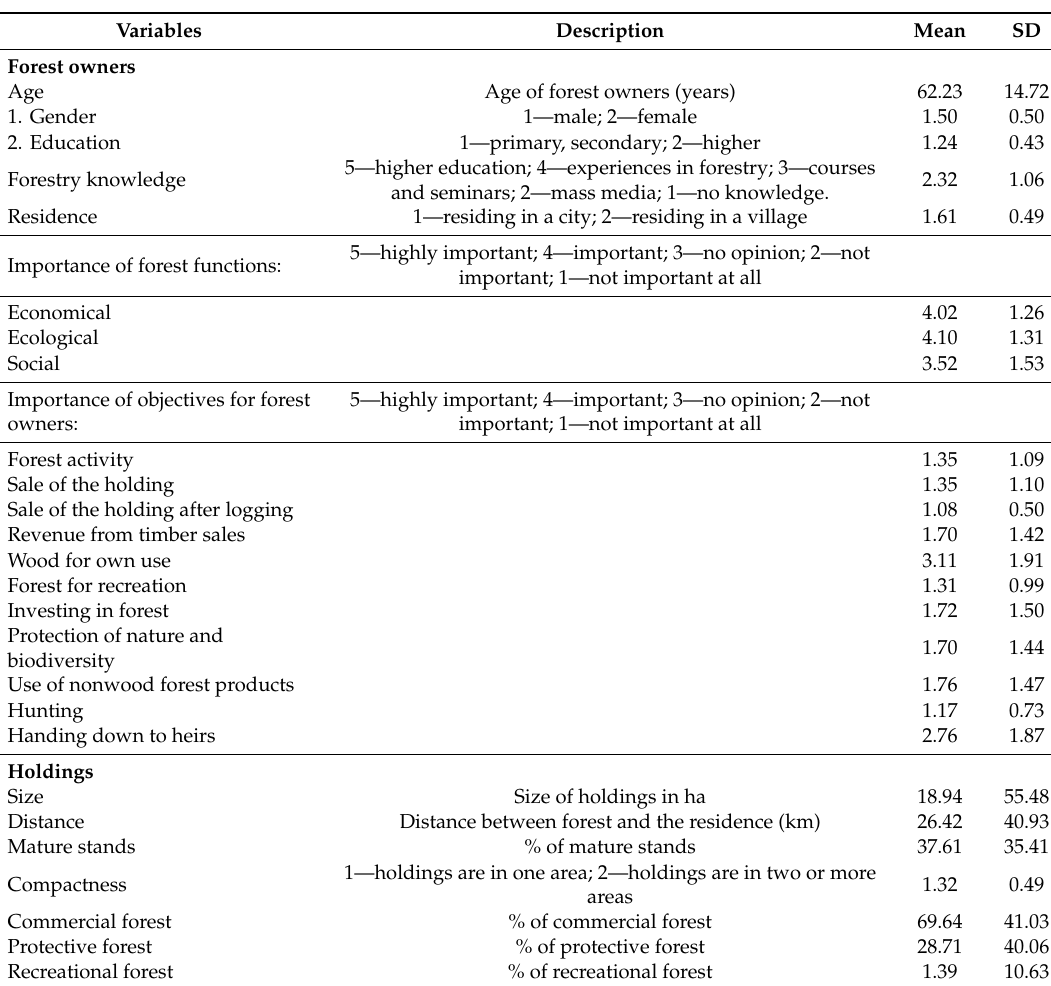
Table 3. Description of independent variables. SD = standard